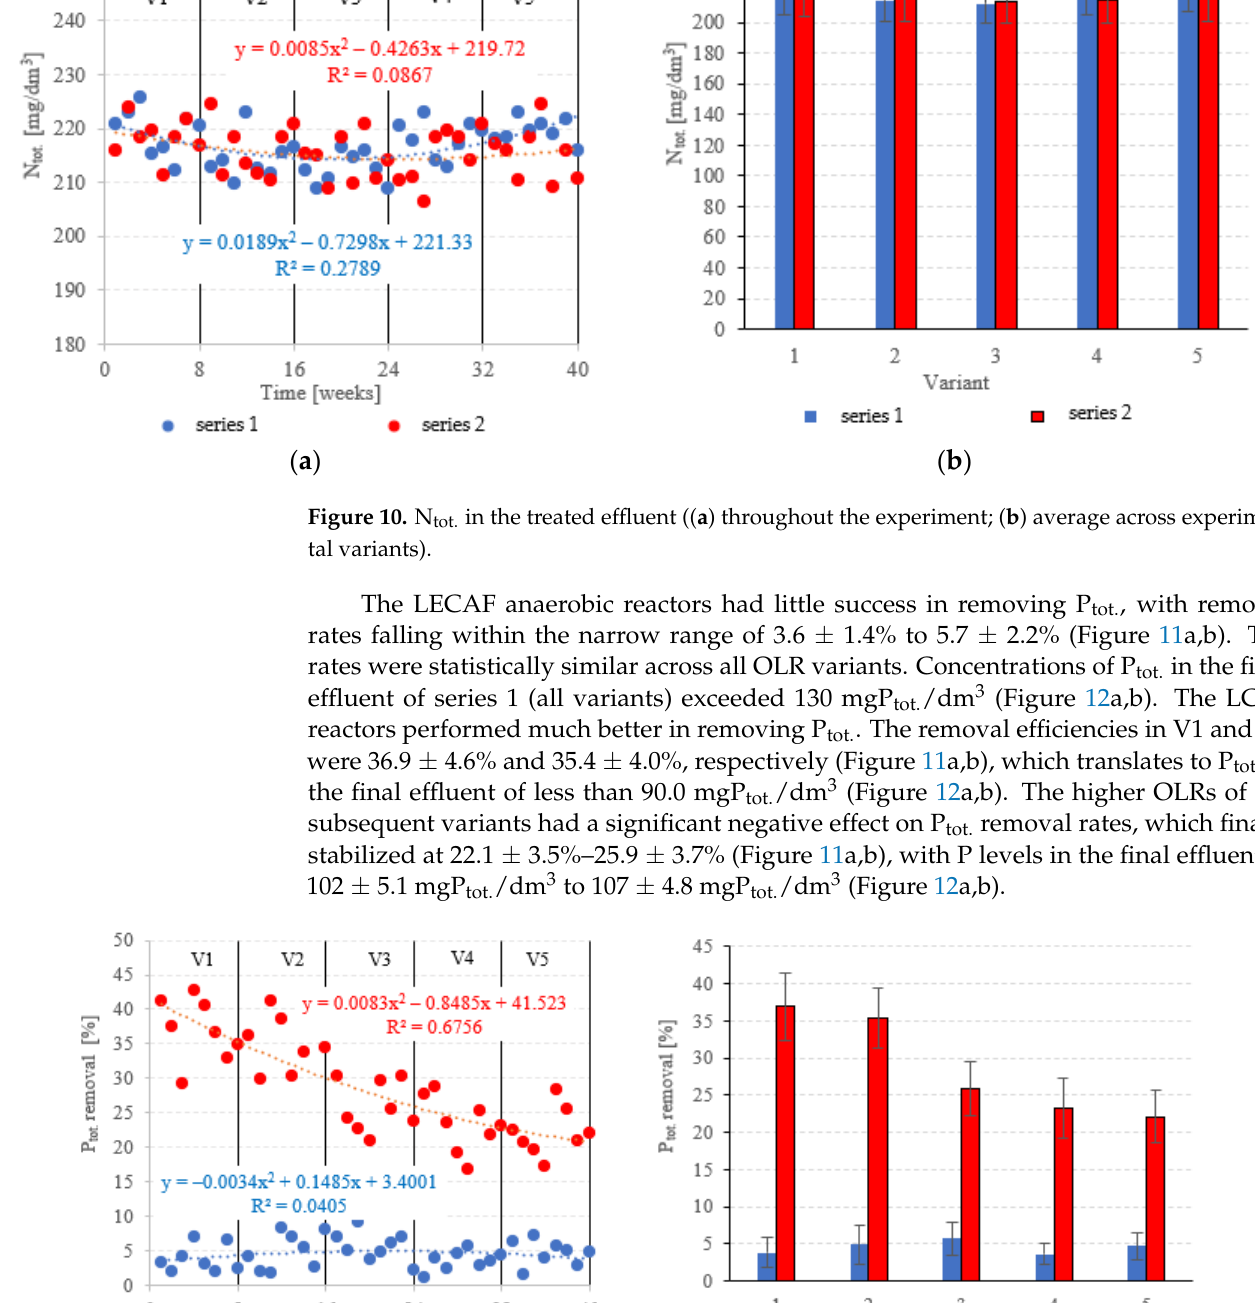
Figure 9. N tot. removal (( a ) changes throughout the experiment; ( b ) average across experimental variants).